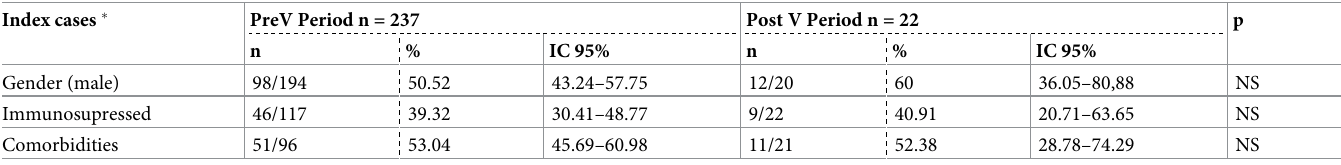
Table 1. Epidemiological and clinical characteristics of index cases in pre- and post-vaccination periods. Index cases